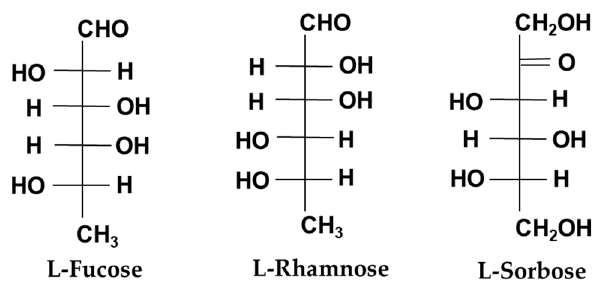
Figure 5. L-hexoses in the food industry.